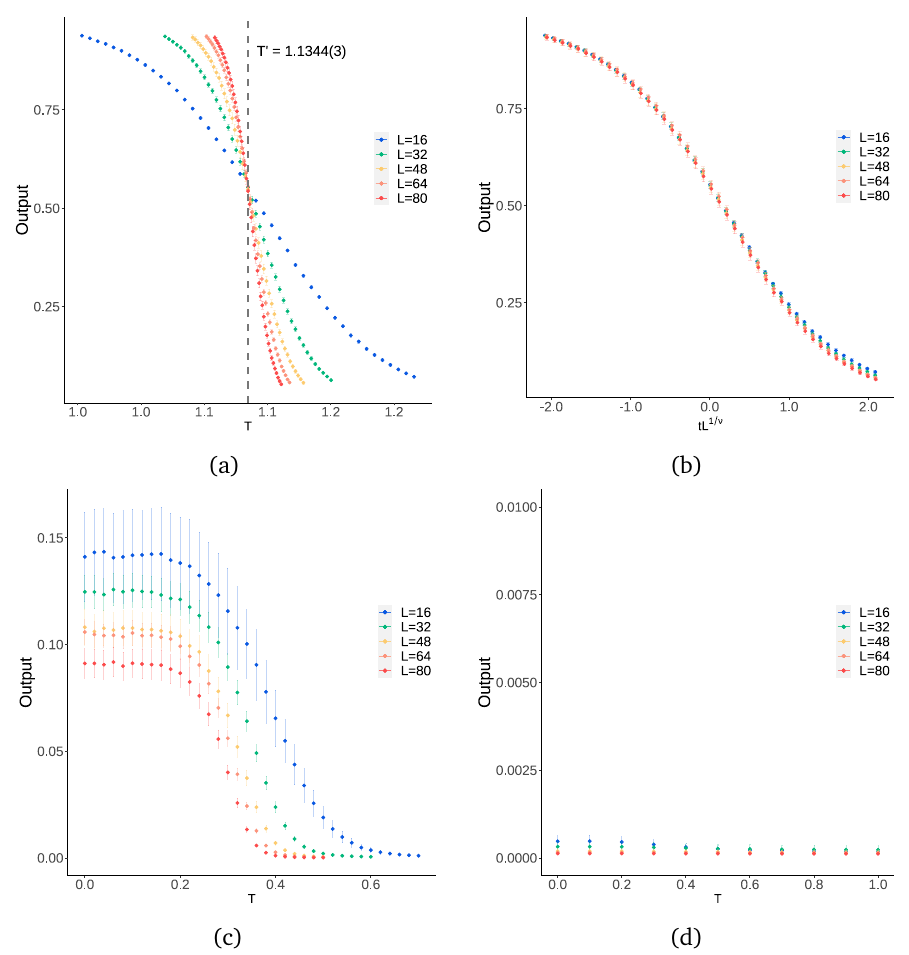
Figure 3: Application of our methodology to the antiferromagnetic Potts model. a–b , Average q / 2-normalized outputs of antiferromagnetic Ising model-trained ANNs versus sampling temperature for spin configurations of the antiferromagnetic Potts models with q = 2 ( a ) and the associated finite-size scaled results ( b ). c–d , The corresponding results for q = 3 ( c ) and q = 4 ( d ). The error bars shown are 99.7% confidence